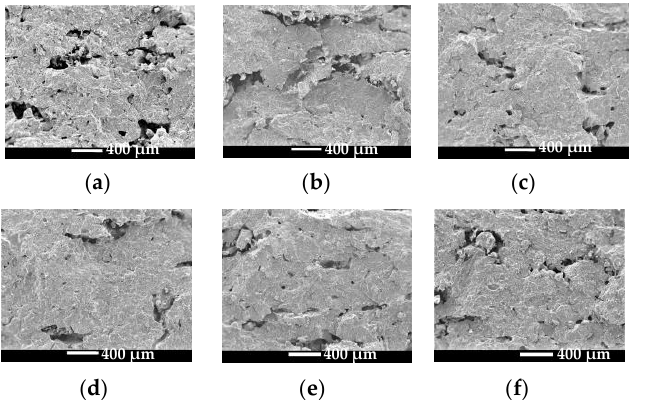
Figure 7. SEM images of the fracture surface of the green part and the parts after thermal post- processing: ( a ) the green part; ( b ) 65 °C; ( c ) 100 °C; ( d ) 110 °C; ( e ) 120 °C; ( f ) 130 °C.